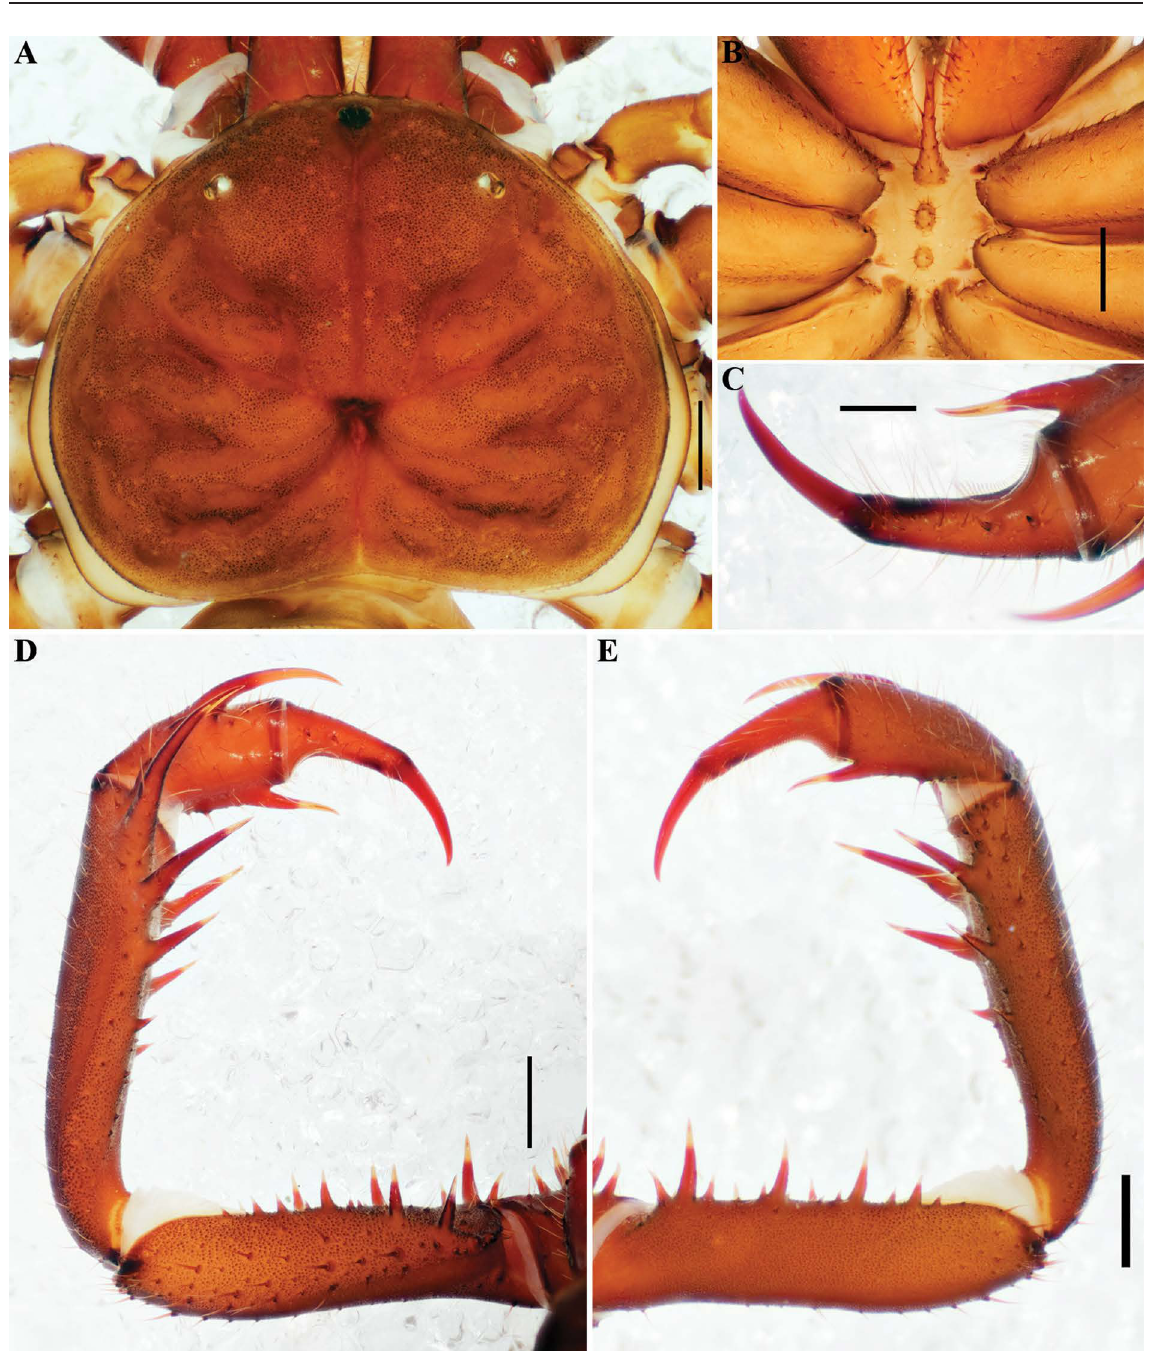
Fig. 71. Charinus puri sp. nov. (MNRJ 9223), general morphology. A . Carapace, dorsal view. B . Sternum, ventral view. C . Pedipalp tarsus, frontal view. D . Pedipalp, dorsal view. E . Pedipalp, ventral view. Scale bars: A–B, D–E = 1 mm; C =